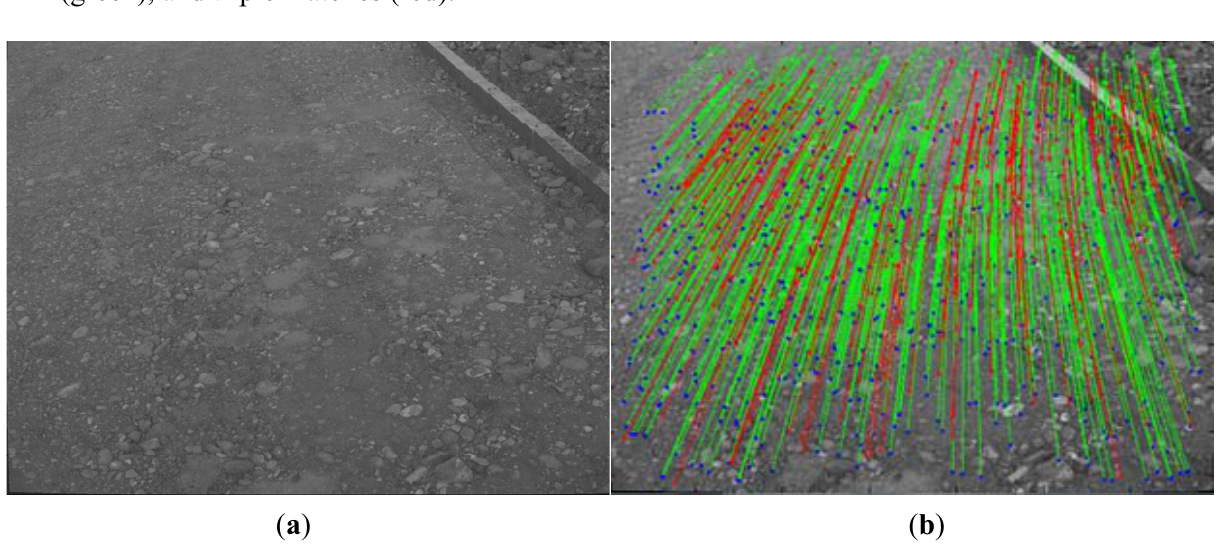
(green), and triple matches